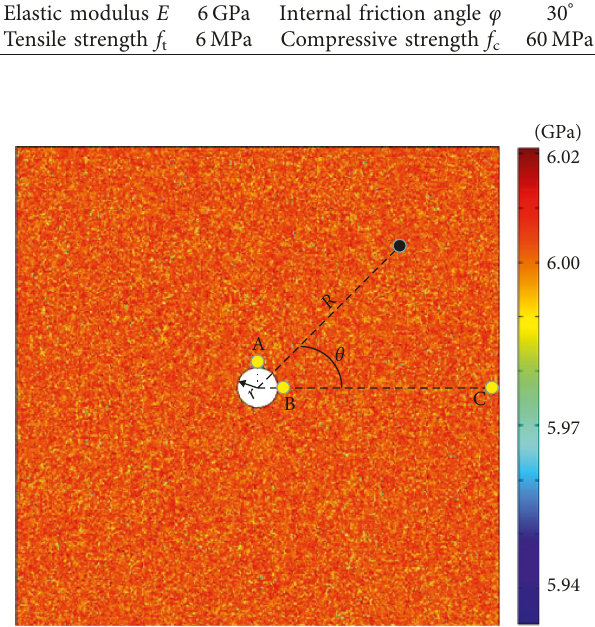
Figure 4: Distribution diagram of initial elastic modulus ( m